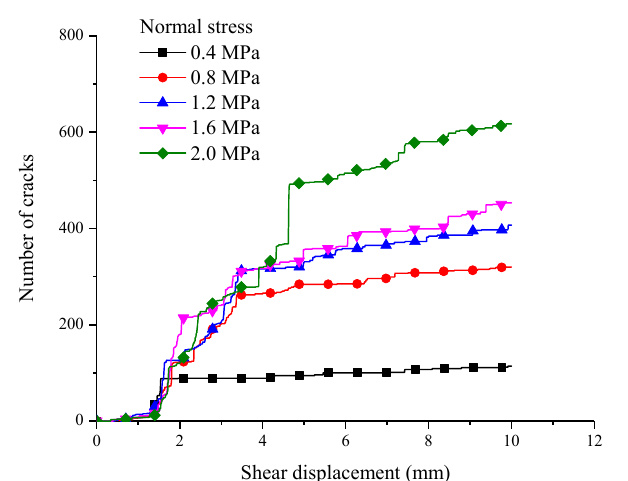
Figure 4. The relationship between the number of microcracks and shear displacement.